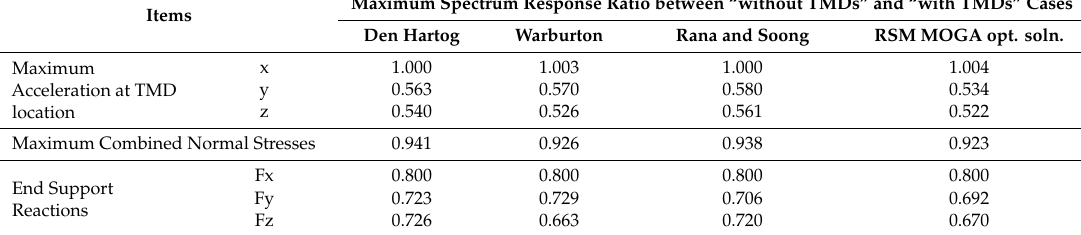
Table 6. Comparison of the maximum spectral response ratios according to whether TMDs were installed and the di ff erence between the optimal design formula /